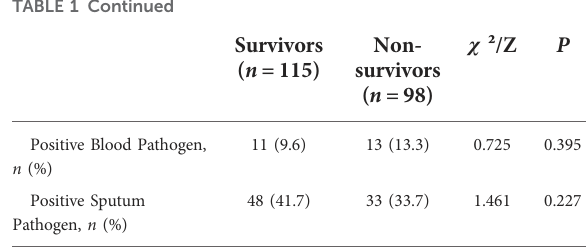
WAZ, weight-for-age z-score; PIM3, Pediatric Index of Mortality 3 score; PELOD2, Pediatric Logistic Organ Dysfunction 2 score; OI, oxygenation index; PARDS, pediatric acute respiratory distress syndrome; PaO2, partial pressure of oxygen of arterial blood; PaCO2: partial pressure of carbon dioxide of arterial